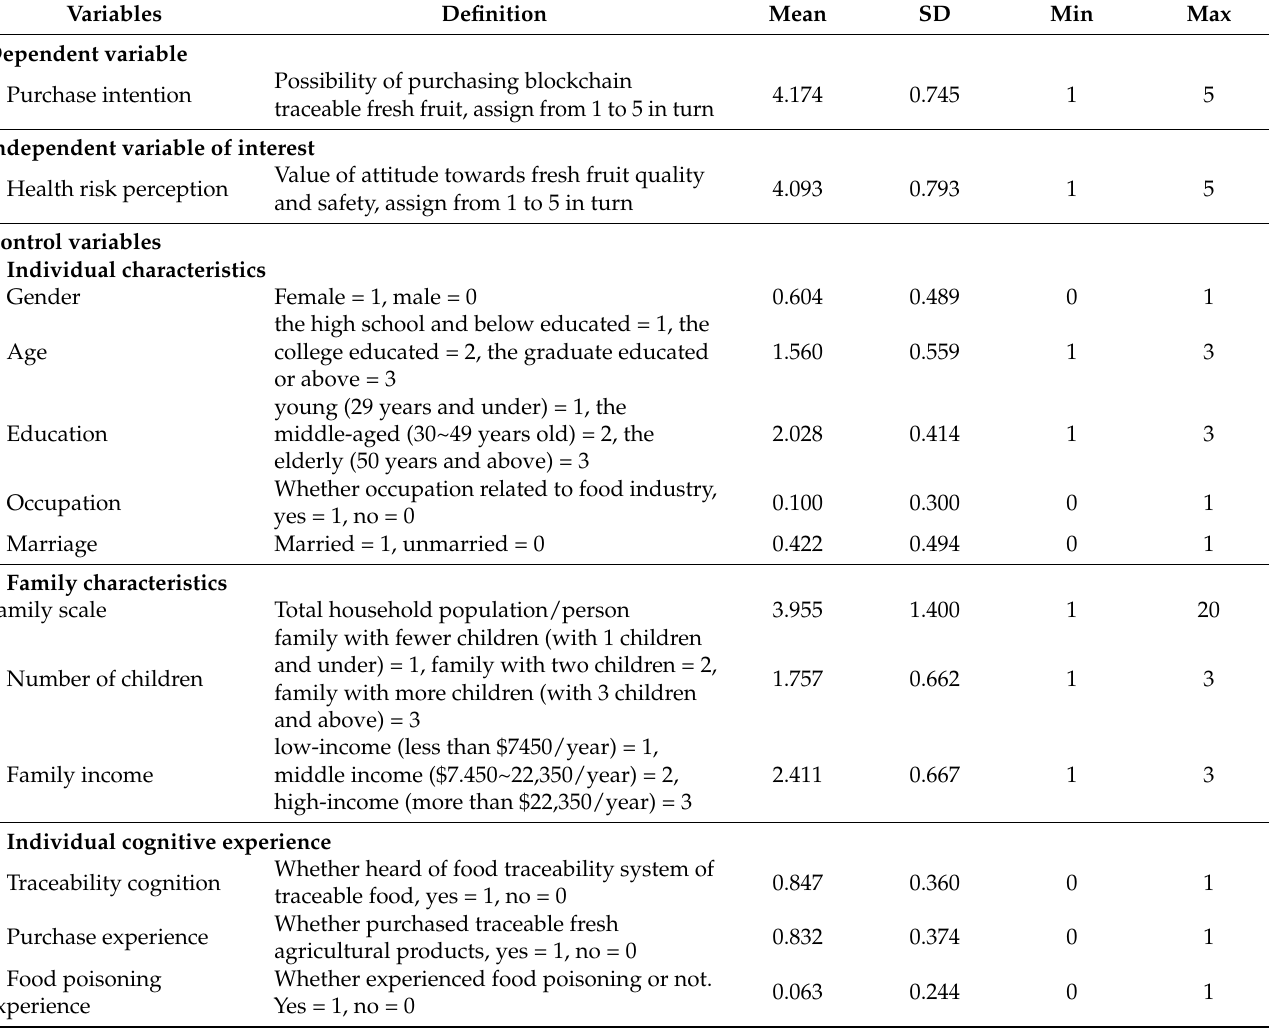
Table 1. Variable definition and descriptive